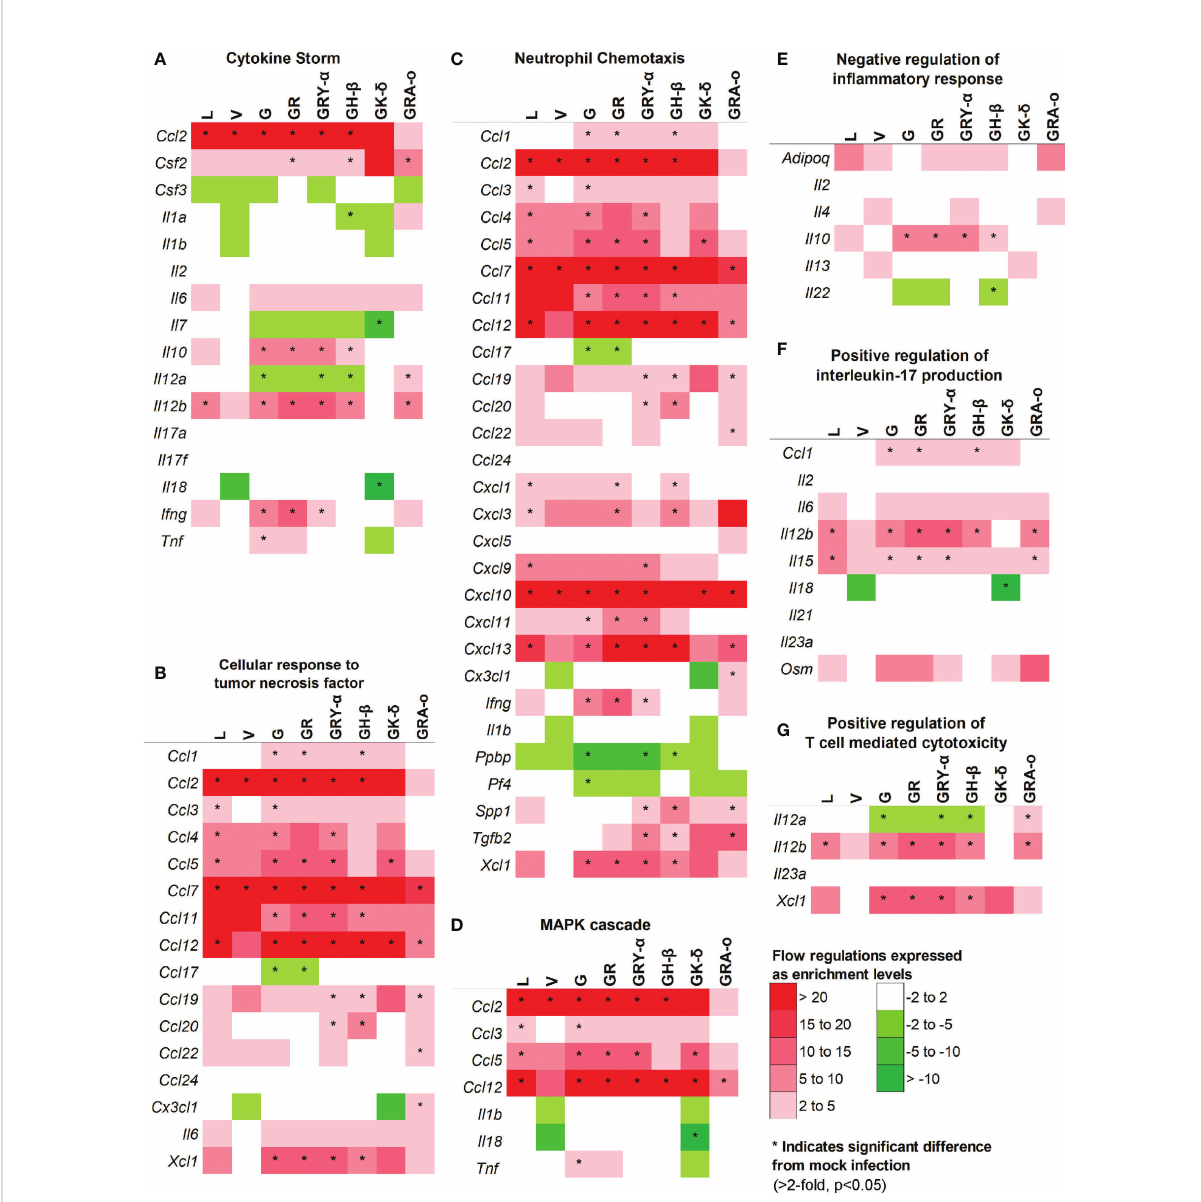
FIGURE 5 Comparison of differentially expressed genes in selected pathways relevant to cytokine storm and tissue damage at 4 dpi. Differentially regulated cytokines across all groups in pathways related to (A) cytokine storm; (B) cellular response to TNF (C) neutrophil chemotaxis (D) MAPK cascade (E) negative regulation of in fl ammatory responses (F) positive regulation of IL-17 production (G) positive regulation of T-cell mediated cytotoxicity. Color scale indicate level of averaged fold-regulation changes across the groups, * indicate signi fi cant difference in fold-regulation changes (>2-fold, p<0.05) between infected and mock infected